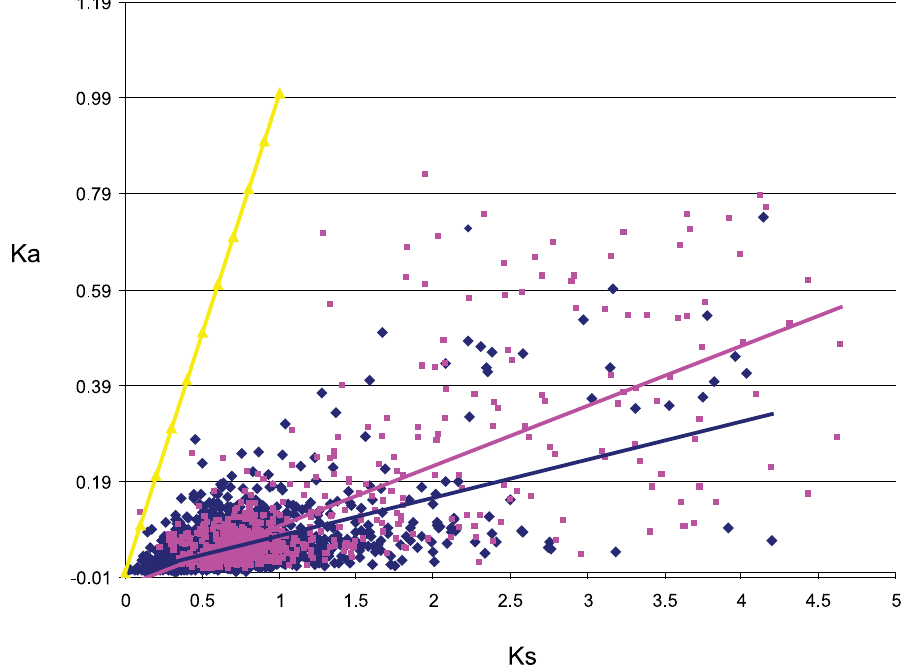
Figure 5. Rates of synonymous (Ks) and non-synonymous substitutions (Ka) in orthologous genes of R.etli and R.leguminosarum . - Neutrality line (Ka=Ks) is indicated in yellow. Linear regressions for CO class (blue color line and diamonds) and NC class (rose color line and diamonds) are indicated. As neutrality assumes equal nucleotide substitutions rates per synonymous and non-synonymous sites, points under the neutrality line indicate negative selection. Strong selective constraints are acting on genes of the CHR-O class (R2 = 0.6124; P % 0.001) but are slightly less intense for some genes of the N-CHR class (R2= 0.5094), as can be seen by the dispersion of the rose color diamonds.